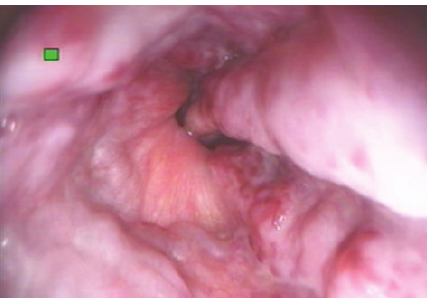
Figure 2: Di ff erent types of esophageal varices on endoscopic